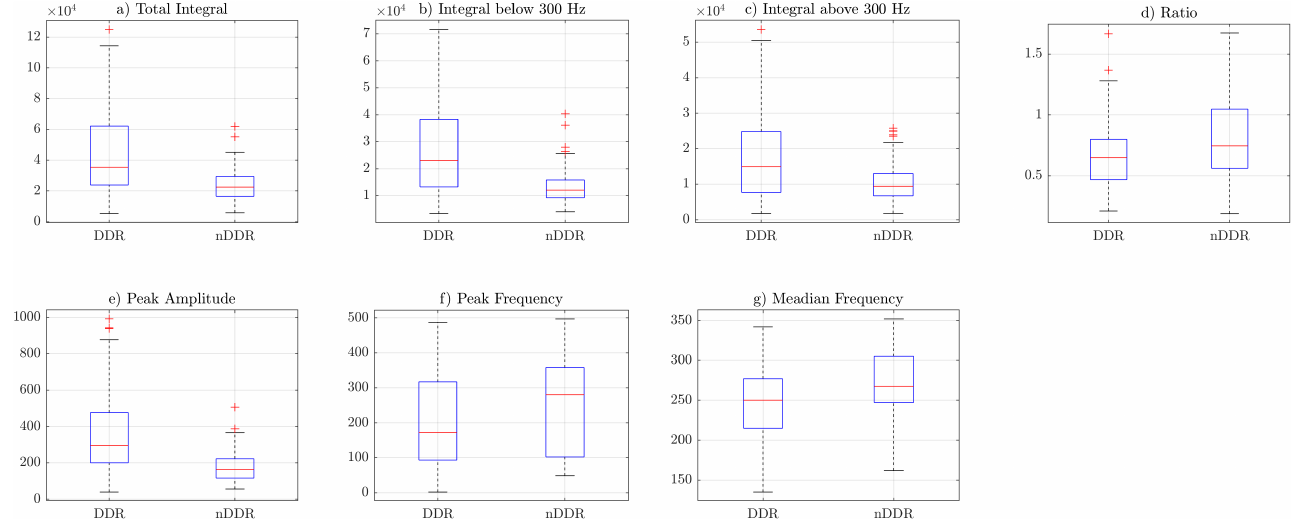
Figure 5. Box plots of norm2 features: ( a ) TI feature, ( b ) IB3 feature, ( c ) IA3 feature, ( d ) IBAR feature, ( e ) PA feature, ( f ) PF feature, ( g ) MF